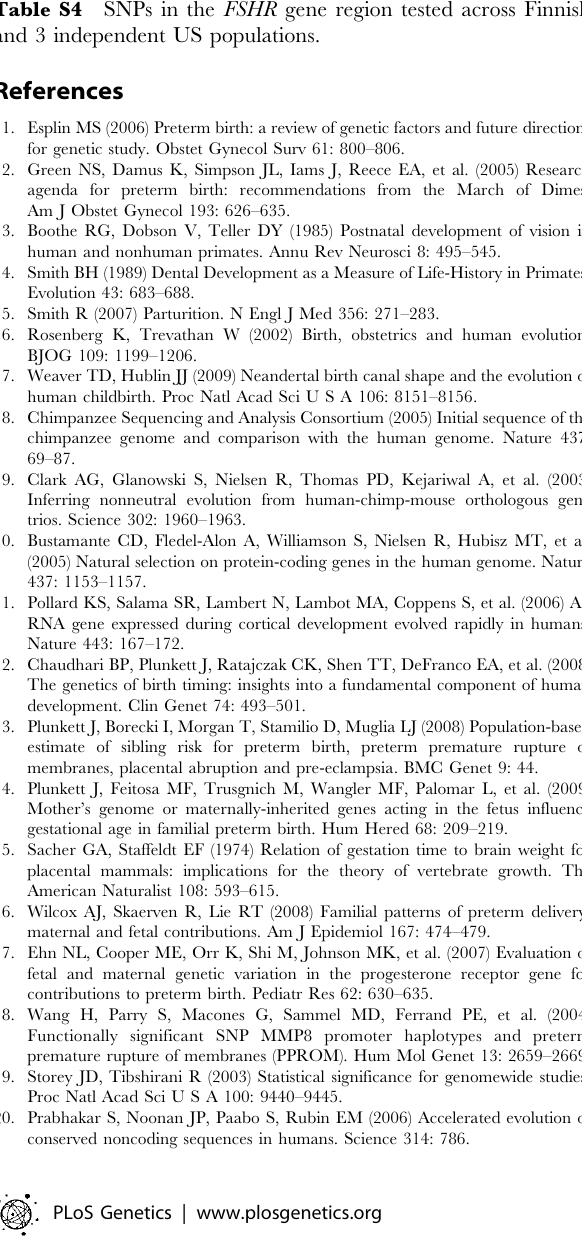
Table S5 Comparison of association results for SNPs in the FSHR gene region in Finnish mothers for the binary phenotype preterm birth affection status and quantitative phenotypes gestational age and birthweight